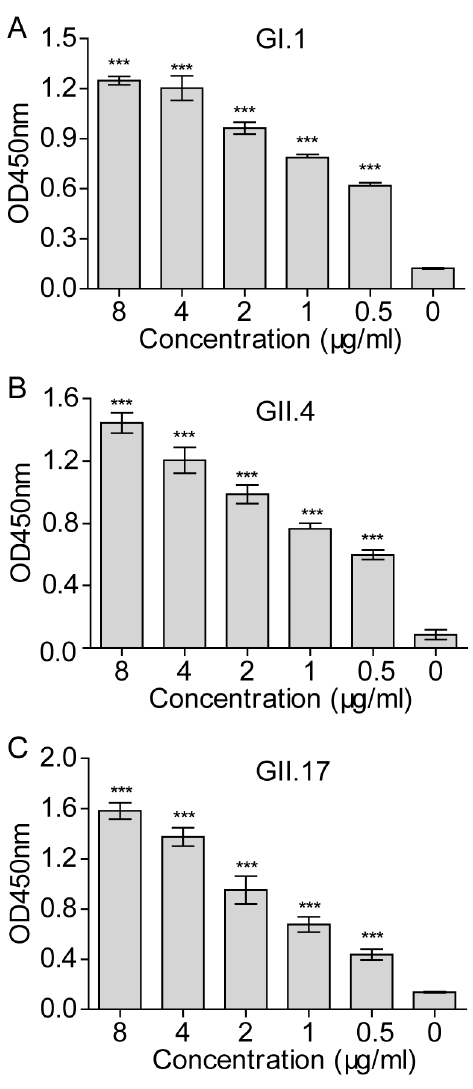
Figure 4. Norovirus virus-like particles (NoVs VLPs) attachment to 293T-FUT2 cells in a dose-dependent manner. Various doses of NoV VLPs were incubated with 293T-FUT2 cells for 1 h at 4 °C and detected by cellular ELISA with rabbit antisera against GI.1, GII.4, or GII.17 VLPs. ( A ) GI.1VLP attachment to 293T-FUT2 cells; ( B ) GII.4 VLP attachment to 293T-FUT2 cells; ( C ) GII.17 VLP attachment to 293T-FUT2 cells. Data are the means ± SD of OD 450nm values for triple wells. Statistical significance was determined by the Student’s t -test using GraphPad Prism version 5, and values are indicated as *** p < 0.001. All of the experiments were replicated three times.